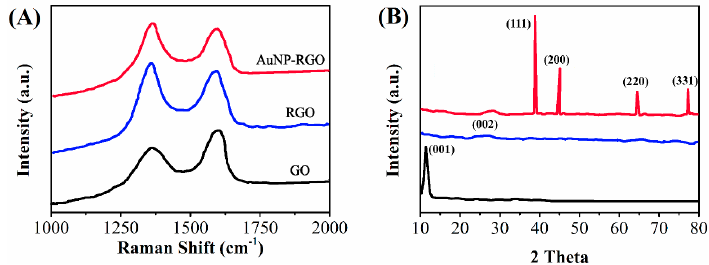
Figure 2. ( A ) Raman spectra and ( B ) XRD patterns of GO, RGO, and RGO/AuNP (Au nanoparticle/ reduced graphene oxide) nanocomposite.